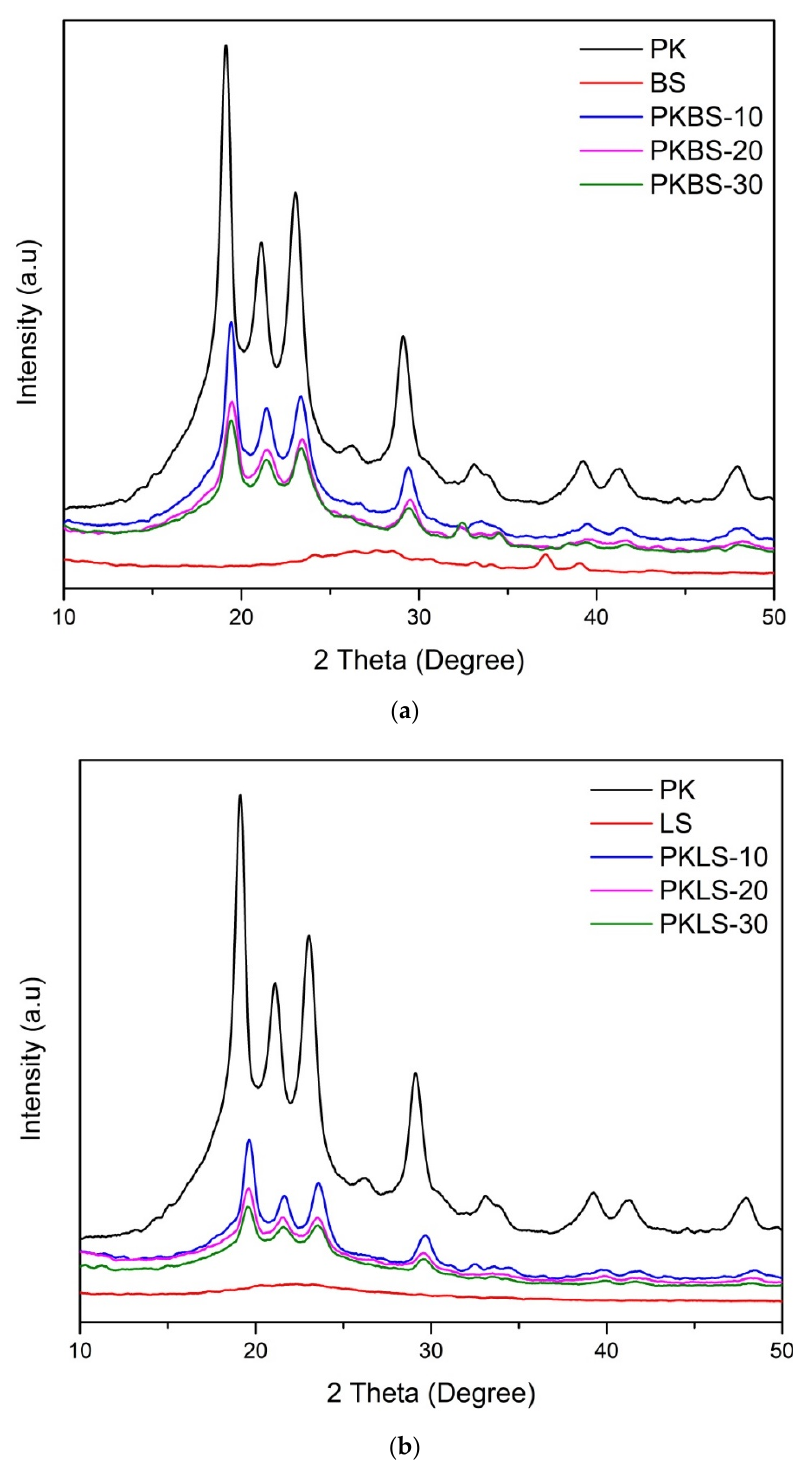
Figure 1. XRD patterns showing the effect of the nano-SiO 2 fillers on the crystallinity of PEEK: ( a ) nanocomposites filled with hydrophobic nano-SiO 2 and ( b ) nanocomposites filled with hydrophilic nano-SiO 2 .